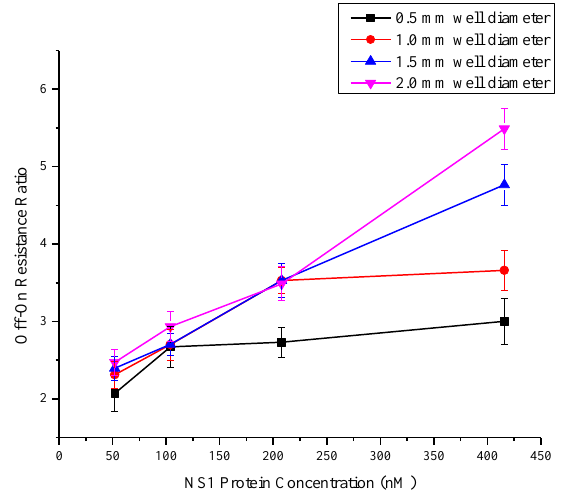
Figure 12. Off-on resistance ratio curve for four different wells diameter (0.5, 1, 1.5 and 2 mm) when applied with four concentrations NS1 protein (52, 104, 208 and 416 nM).